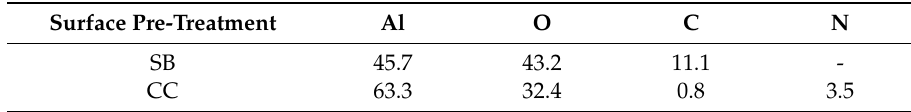
Table 1. Average chemical composition (in wt %) of the SB and CC pre-treated AA2024-T3 surface after 28 days of accelerated aging by EDS